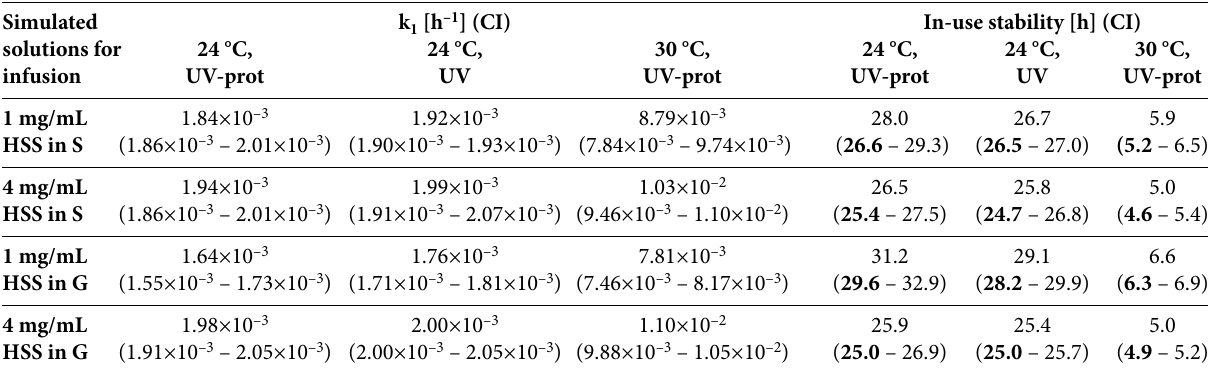
Table 3. First-order rate constants (k 1 ) and in-use stability (t 95% ) for hydrocortisone sodium succinate (HSS) at two concentrations (1 mg/mL and 4 mg/mL) in the simulated solutions for infusion under different storage conditions. Simulated k 1 [h –1 ] (CI) In-use stability [h] (CI) solutions for 24 °C, infusion